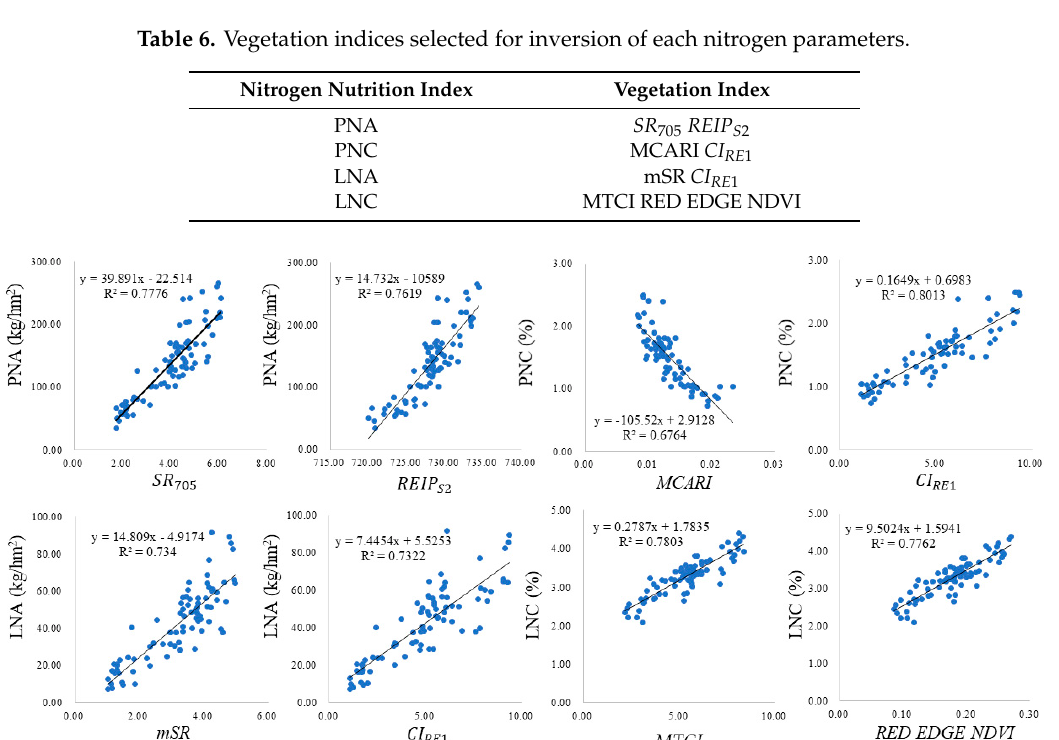
Figure 6. Relationship between nitrogen nutrition parameters and vegetation indices.